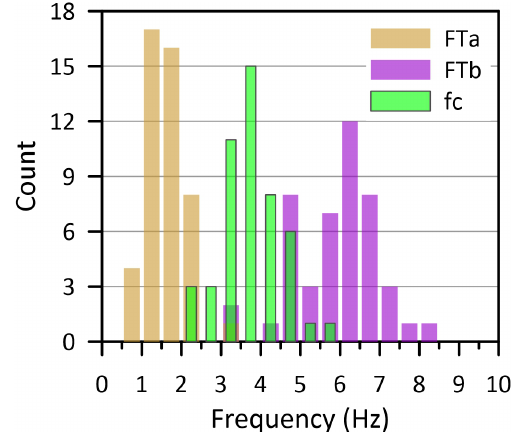
Figure 3. Distribution of the corner frequencies f c , and the fre- quency thresholds FT a and FT b above and below which the 95% of the cumulative spectral energy is